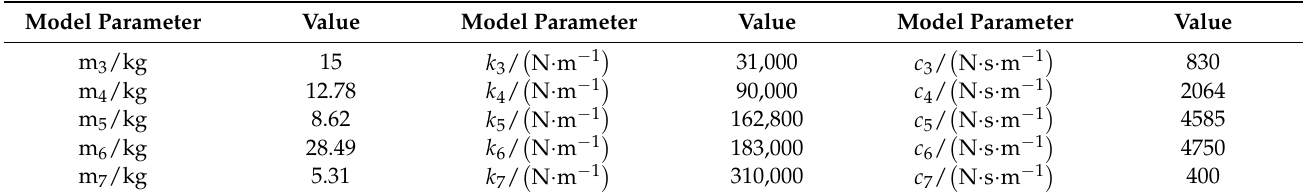
Table 2. Model parameters of driver model.